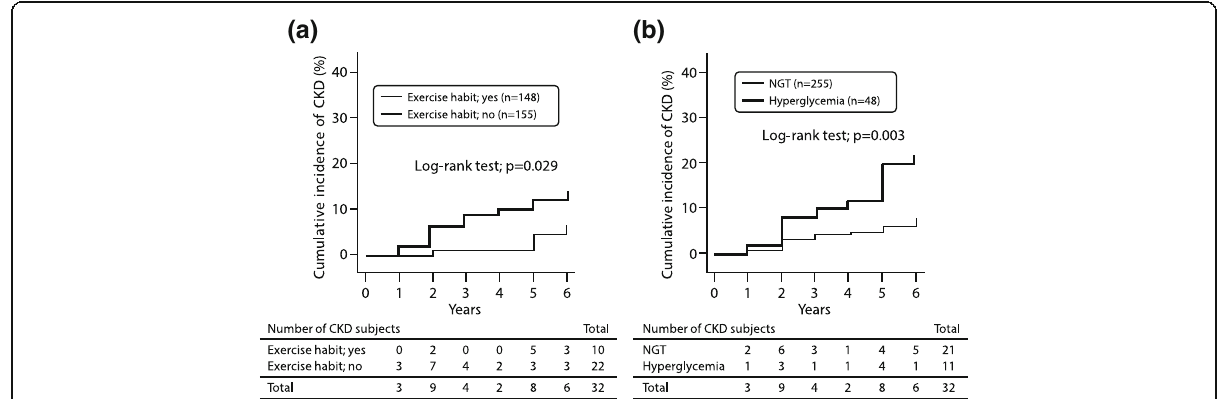
Fig. 2 The cumulative incidence of CKD after a 6-year follow-up period in subjects according to the performance/non-performance of habitual